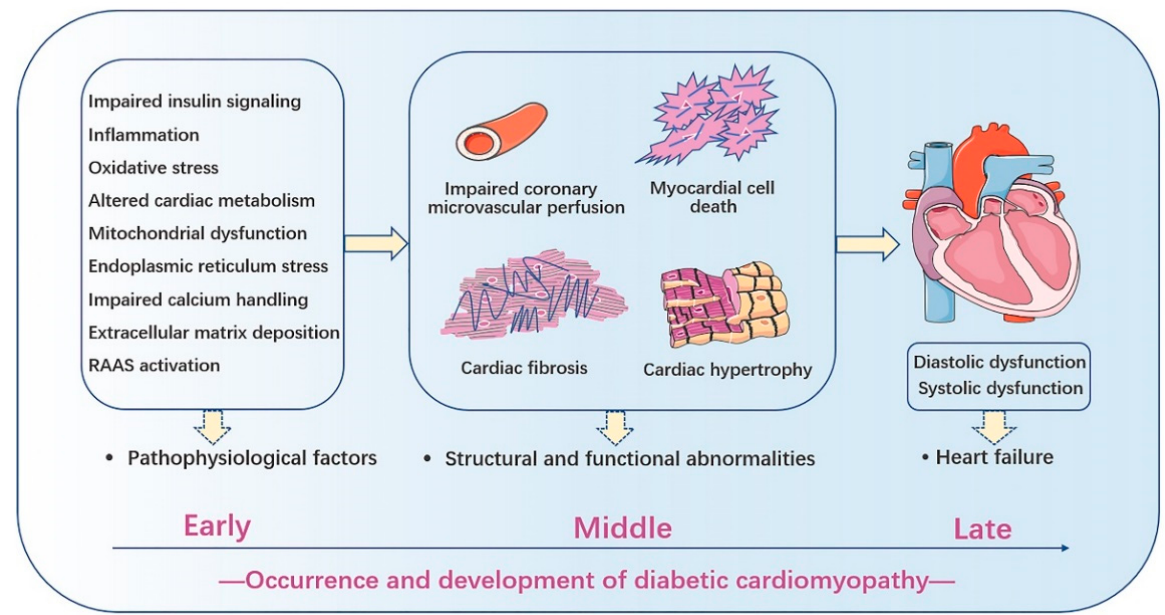
Figure 1. Thepathophysiologicalfactors, structuralandfunctionalabnormalitiesindiabeticcardiomyopathy. Figure 1. The pathophysiological factors, structural and functional abnormalities in dia- The pathophysiological factors cause the following structural and functional character- betic cardiomyopathy. istics of diabetic cardiomyopathy, including myocardial cell death, cardiac fibrosis, cardiac failure and